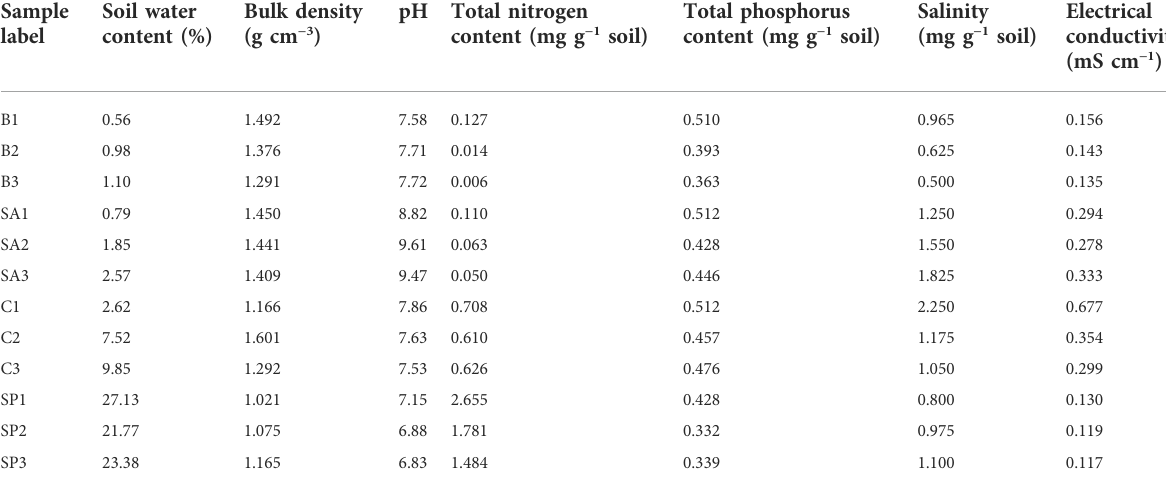
TABLE 2 Chemical and physical characteristics of soils. Sample